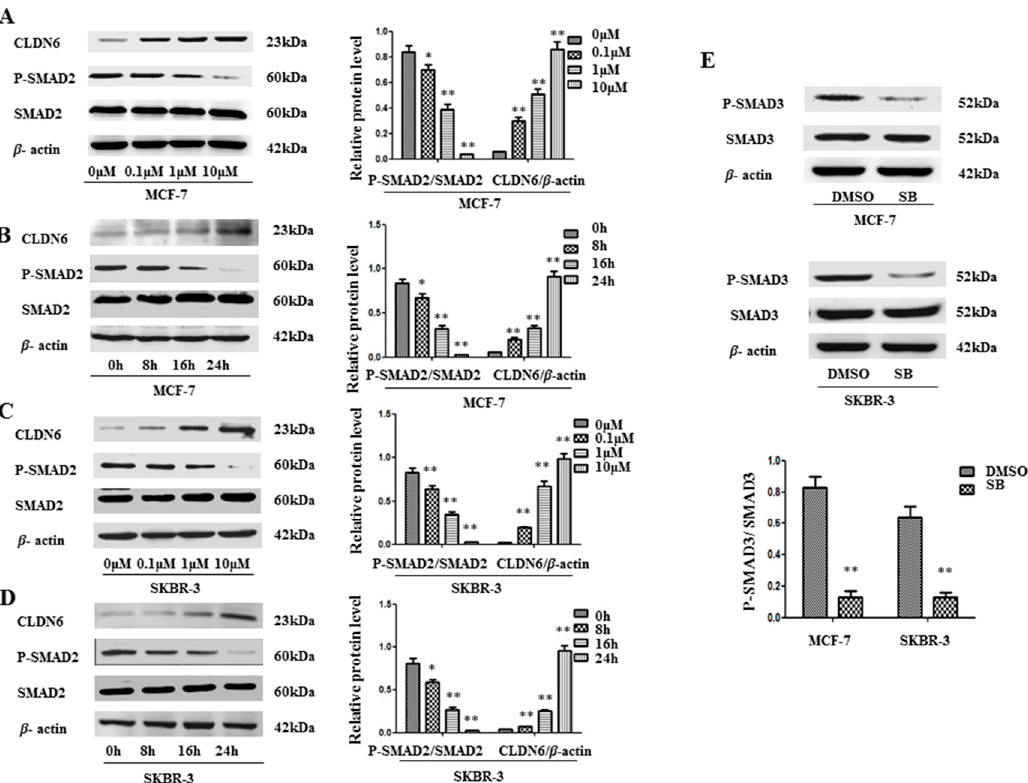
Figure 1. SB431542 inactivated SMAD2 signaling, and suppressed CLDN6 in MCF-7 and SKBR-3 cells. ( A – D ) SB431542 downregulated P-SMAD2 expression in a time- and dose-dependent manner. SB431542 treatment increased CLDN6 and decreased P-SMAD2. ( A , C ) MCF-7 and SKBR-3 cells were incubated with SB431542 for 24 h at the indicated concentrations. ( B , D ) MCF-7 and SKBR-3 cells were incubated with SB431542 at 10 µ M for the indicated time ( E ) P-SMAD3 expression was decreased by SB431542 treatment. Immunoblot analysis was used to determine the expression of P-SMAD2, CLDN6, and P-SMAD3. Results of densitometry analysis of relative expression levels of P-SMAD2 and P-SMAD3 after normalization to SMAD2 and SMAD3 and CLDN6 expression levels after normalization to loading control β -actin are presented (* p < 0.05 and ** p < 0.01 are considered statistically significant and highly statistically significant, respectively). Bars represent mean ± SE ( n = 3).